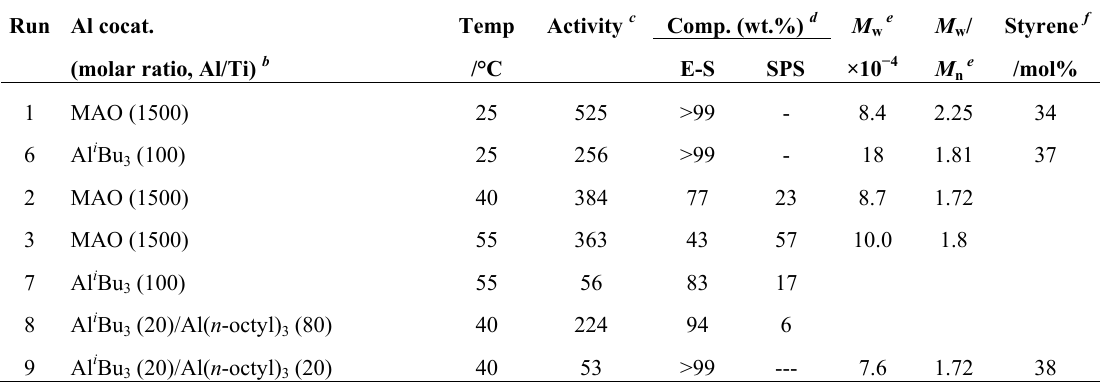
Ethylene/styrene copolymerization